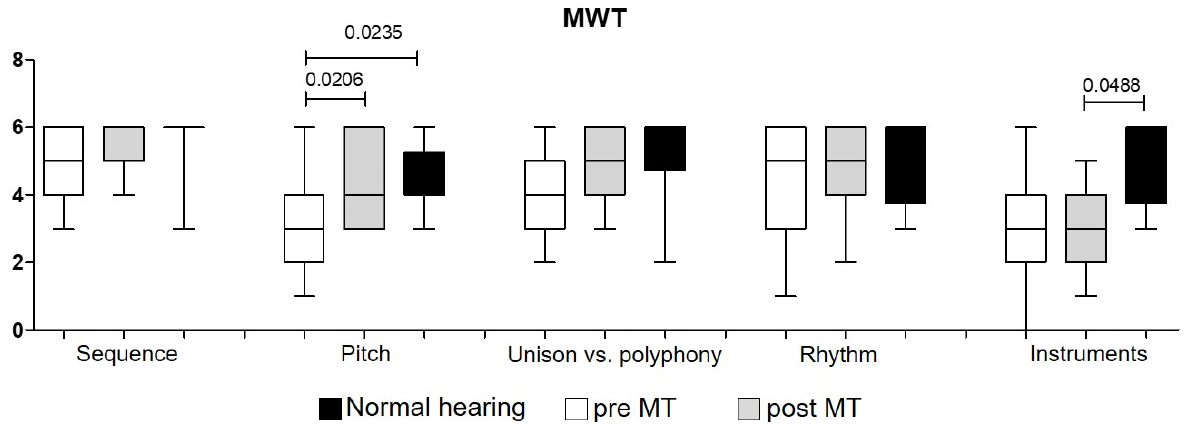
Figure 4. The music perception test (MWT) evaluating different parameters in music skills containing the following musical aspects: detection of sound sequences, pitch discrimination, differentiation of one or two notes (unison vs. polyphony), rhythm, discrimination, and recognition of different